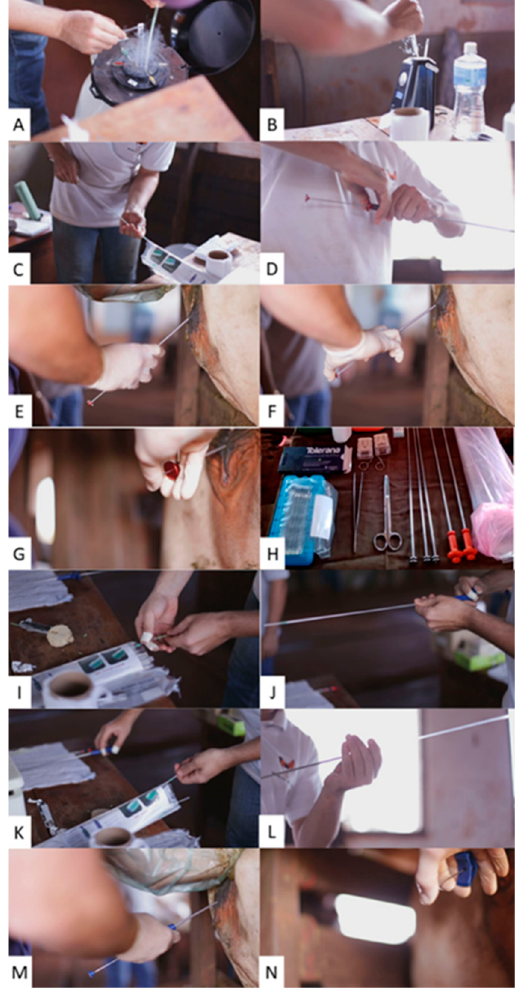
Figure 1. Procedure for the administration of Tolerana Bovines IA. in sequential acts, they follow illustrations of the following steps: ( A ) removal of the semen reed from the nitrogen canister; ( B ) semen thawing; ( C , D ) assembly of the applicator with a semen reed; ( E ) passage of the applicator through the cervix; ( F , G ) application of semen to the body of the uterus ( H ) cut the end of Tolerana’s reed; ( I – L ) assembly of the applicator with Tolerana IA reed; ( M ) passage of the applicator through the cervix; ( N ) application of Tolerana Bovines IA in the body of the uterus. The criteria for defining the used BSC were based on the descriptions by Machado et al.